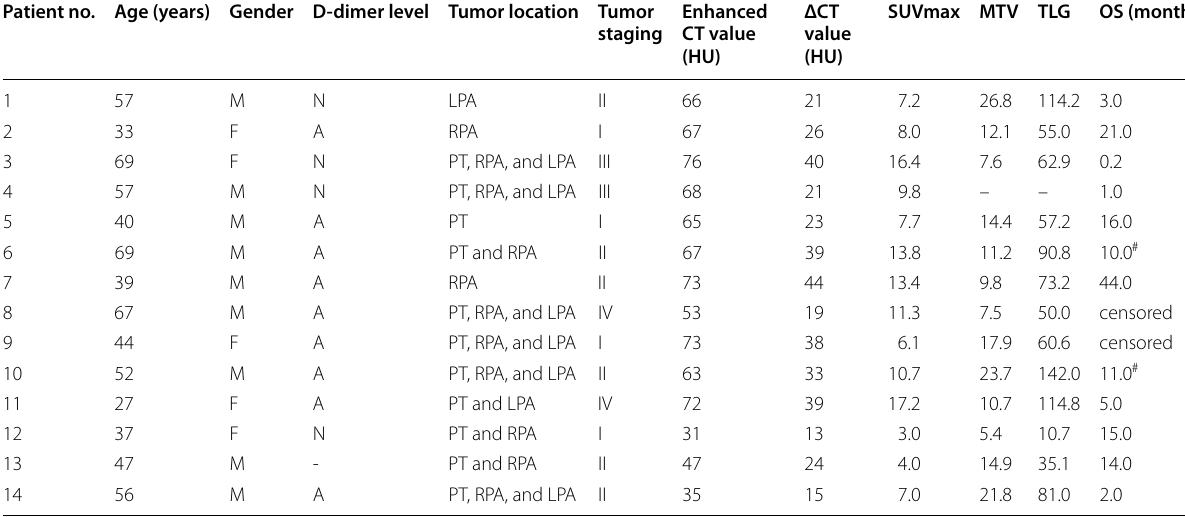
Table 2 Detailed characteristics of the 14 patients with PAS